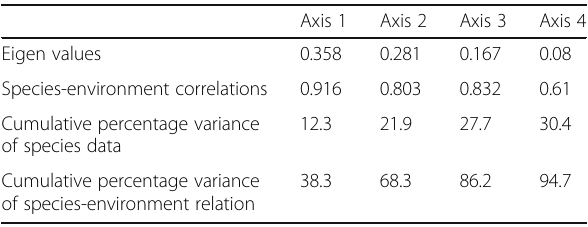
Table 6 Results of canonical correspondence analysis (CCA) showing the strength of the species-environment relationship in the selected stations of the